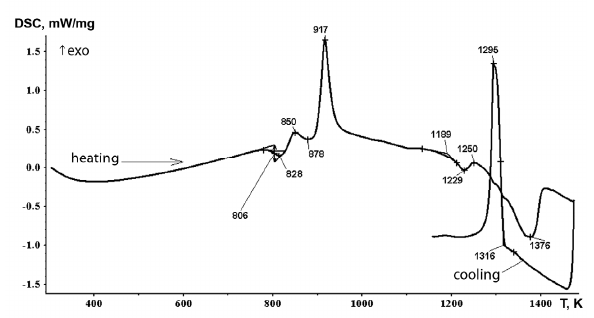
Fig. 3 . Thermogram of quenched oxide sample (heating and cooling was performed at 20 К /min in